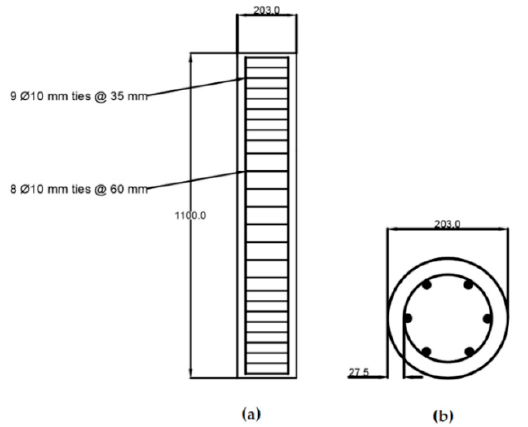
Figure 11. Circular FRP-RC column details: ( a ) column dimension in mm; ( b ) cross section in mm.